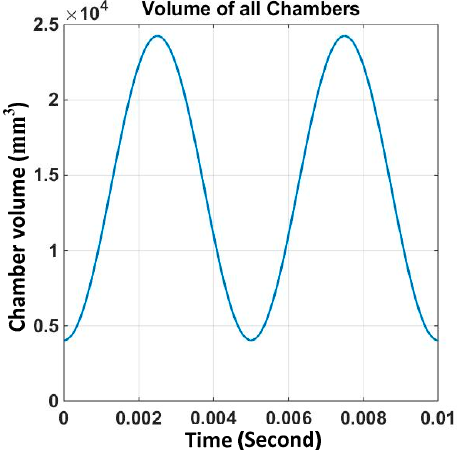
Figure 6. Time-varying process for each chamber volume at a working frequency of 100 Hz.